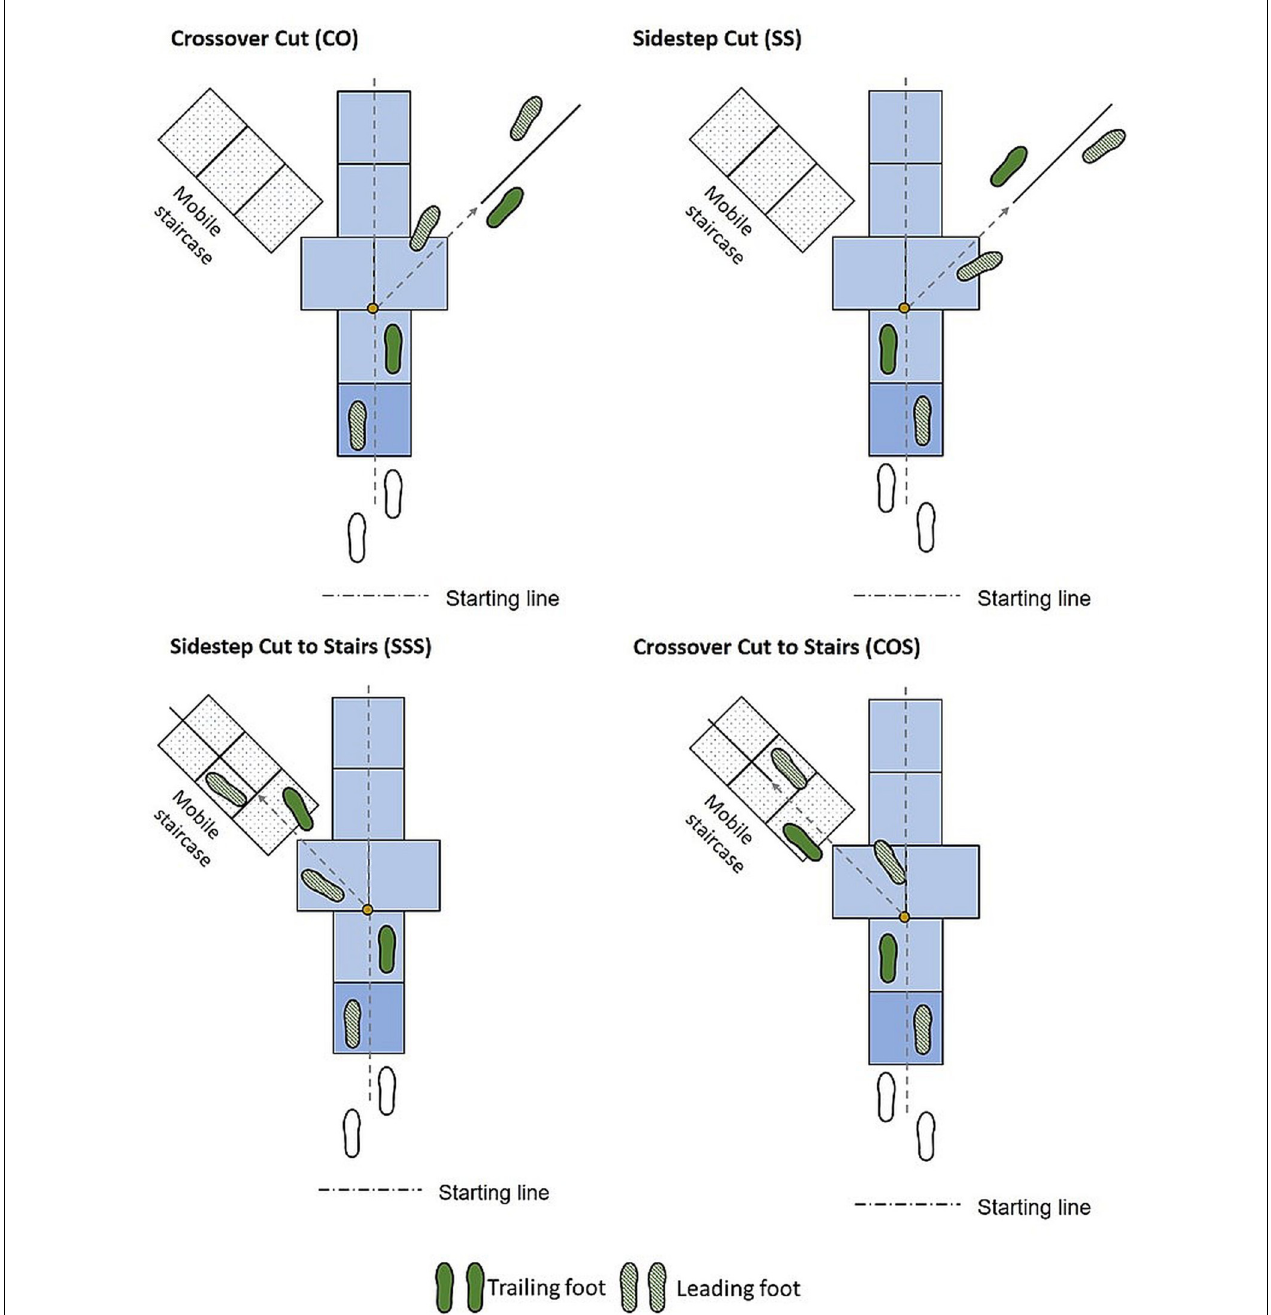
FIGURE 1 | Experimental setup for locomotor transitions. During crossover cut (CO), the swing (trailing) leg crosses over the stance leg, toward the new direction while in sidestep cut (SS), the swing leg is placed laterally, away from the stance leg. In crossover to stair ascent (COS) and sidestep to stair ascent (SSS), following cuts subjects transition to staircase at 45 ◦ to the